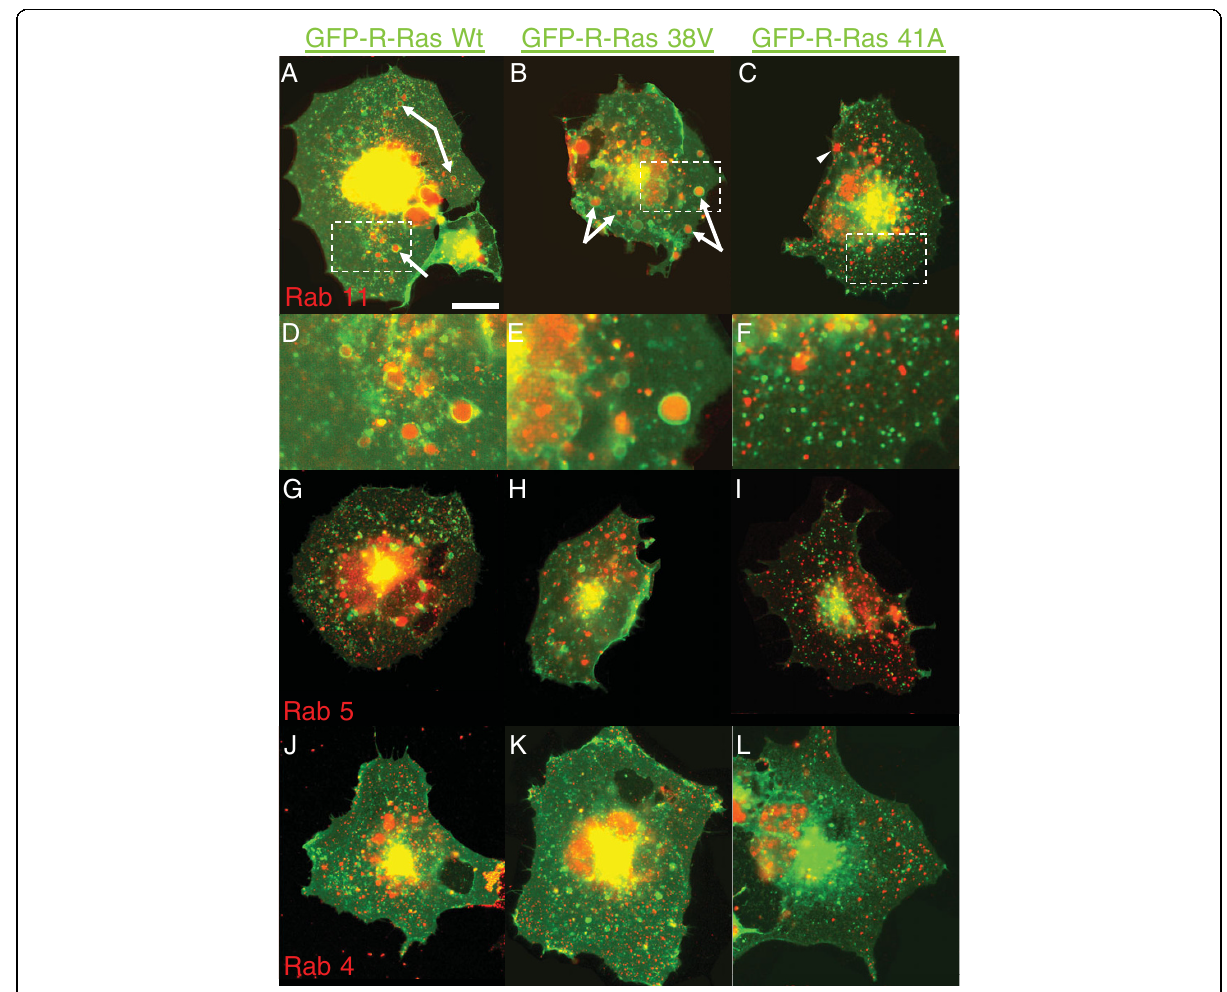
Figure 3 GFP-R-Ras colocalizes with Rab11, but not Rab5- or Rab4-positive endosomal compartments . Cos7 cells were transfected with GFP-R-Ras-(wt), -(38V), or -(41A) and then fixed and stained with antibodies against: (A-F) Rab11; (G-I) Rab5; or (J-L) Rab4. The largest vesicle compartments in 85% of -(wt) and 92% of -(38V) transfected cells were positive for Rab11 (arrows, for -(wt) n = 13 cells and -(38V), n = 12), but not Rab5 or Rab4 (<5%, n = 15 each). Intracellular GFP-R-Ras localized to smaller compartments and PM fluorescence lacked correlation with Rab fluorescence. Scale bar is 20 μ m. (D-F) Insets of cells shown in A-C are shown at 3× zoom to highlight